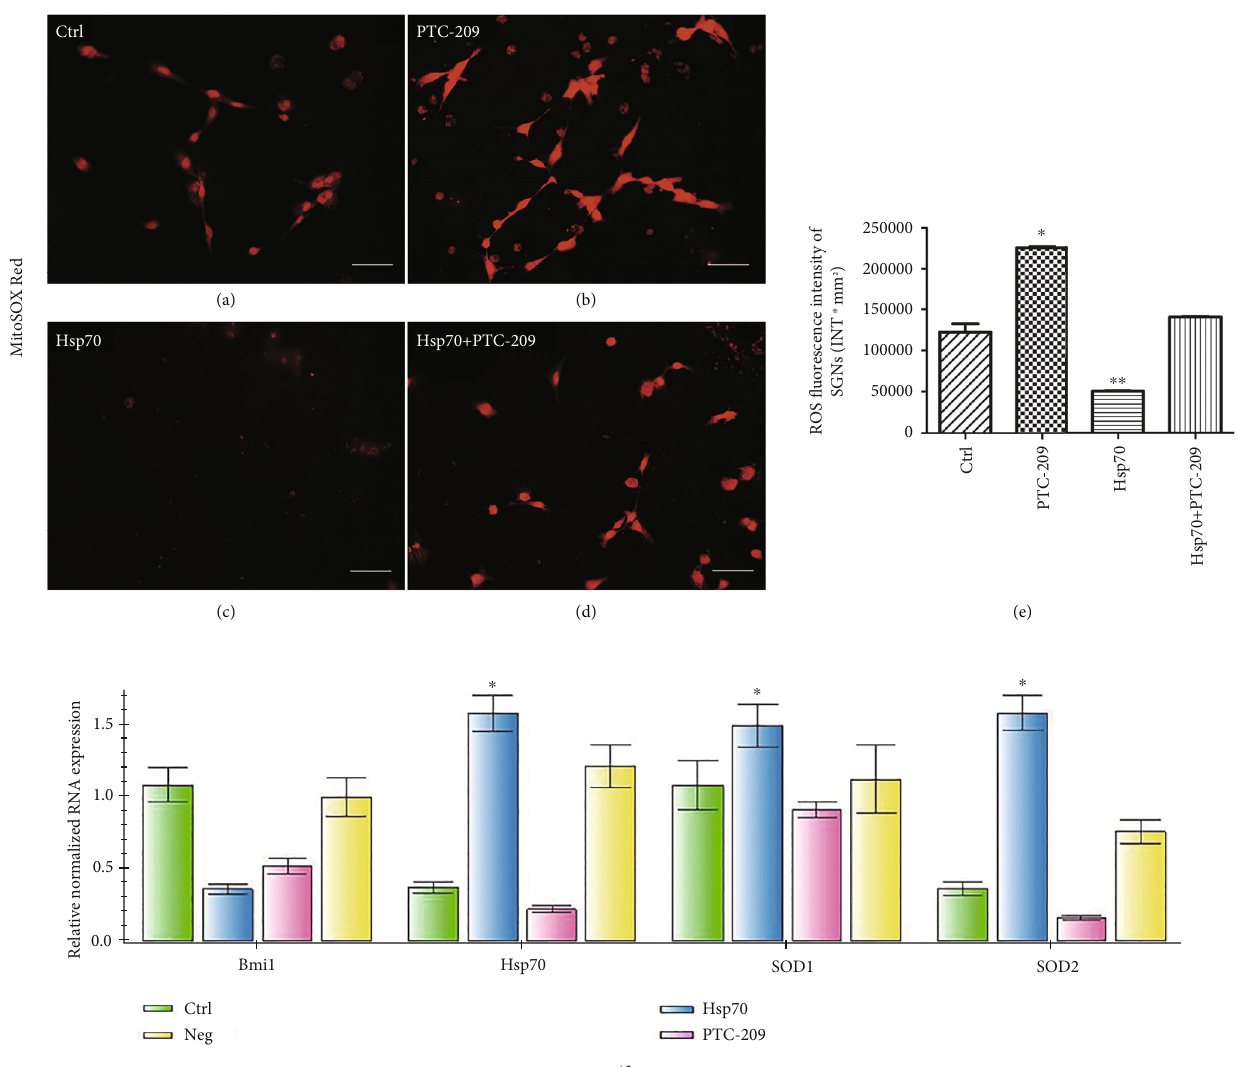
Figure 8: ROS accumulation of di ff erent treatments in SGNs and Bmi1, Hsp70, SOD1, and SOD2 mRNA expression of SGNs in vitro . ROS accumulation in SGNs was showed by MitoSOX Red and was detected with the immune- fl uorescence assay in the control group (a), PTC-209 treated group (b), Hsp70-overexpressing adenovirus group (c), and Hsp70-overexpressing adenovirus followed the PTC-209-treated group (d), while the quantity of ROS accumulation was analyzed by fl uorescence intensity (e). Scale bars represent 50 μ m. Furthermore, values are means ± SD ( N = 80 ). ∗ P < 0 : 05 vs. control group; ∗∗ P < 0 : 05 vs. control group. Statistical analysis of the results presented in (e) was performed with one-way ANOVA ( F = 634 : 9 ; P < 0 : 0001 ), followed by Newman-Keuls ’ post hoc test ( ∗ P < 0 : 05 , ∗∗ P < 0 : 05 ; N = 80 animals from 4 groups). Relative mRNA expressions of Bmi1, Hsp70, SOD1, and SOD2 were determined by quantitative RT-PCR (f). β - Actin RNA level was used as an endogenous control. Values are means ± SD ( n = 12 animals/group). ∗ P < 0 : 05 vs. control